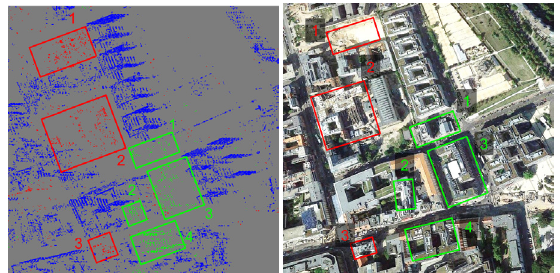
Figure 8. (a) Change detection image and (b) GE image (2014/09/05) for application of monitoring business districts. Red areas, demolished buildings. Green areas, erected buildings.